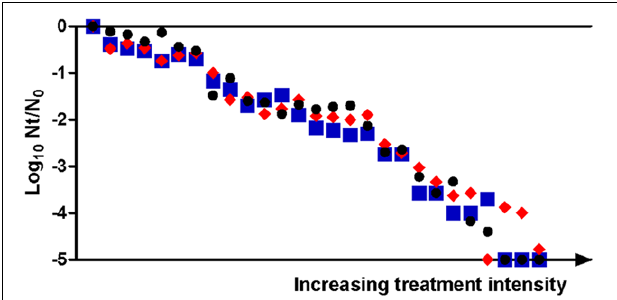
FIGURE 4 | Log 10 cycles of survival fractions detected for E. coli BW25113 in: M9 minimal agar with its MNIC of NaCl (3%) ( • ), M9 minimal agar with betaine 1 mM and its MNIC of NaCl (5%) ( (cid:4) ) or TSAYE with its MNIC of NaCl (5%) ( (cid:117) ). Thermal treatments of 53–59 ◦ C of different durations (0–20 min) were applied in M9 broth to obtain a variety of samples, being each of them depicted in a different